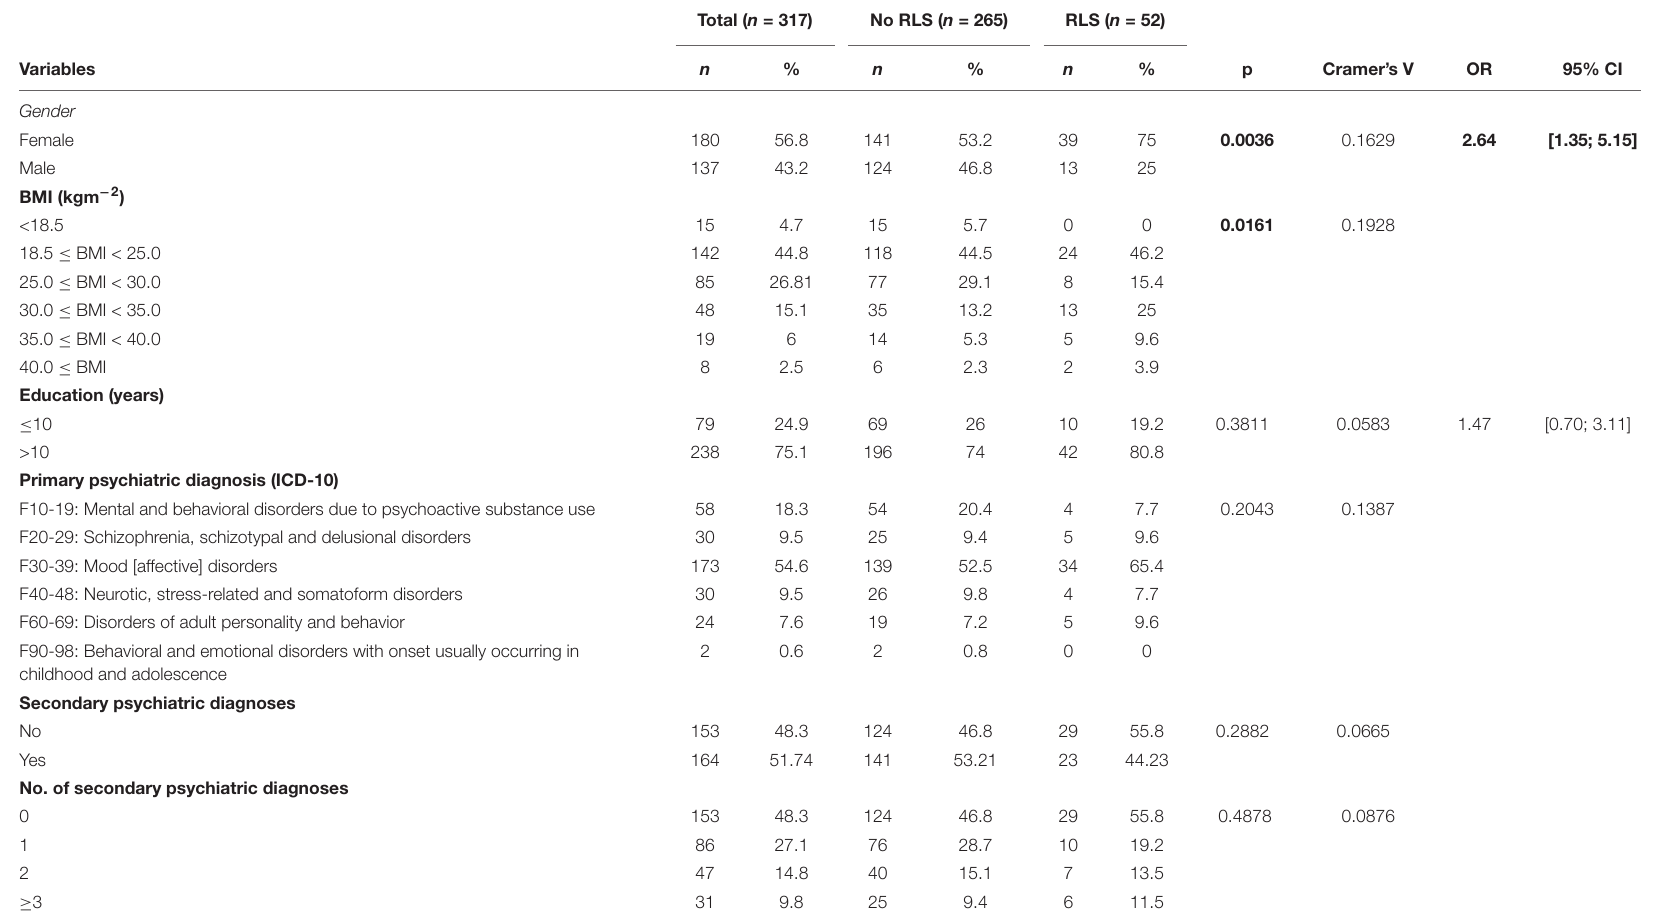
TABLE 1 | Descriptive statistics for variables measured at with ordinal or nominal scale and results of statistical assessment of differences between patients with and without restless legs syndrome (RLS). Total ( n =